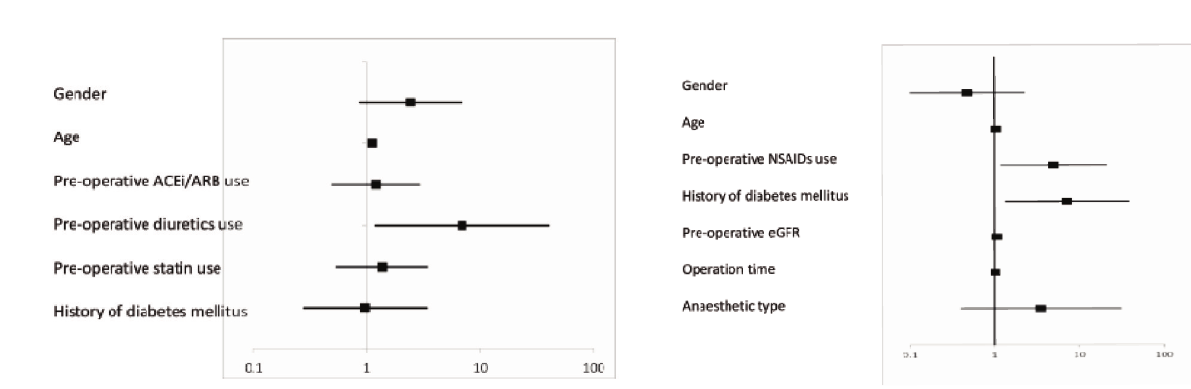
*CKD, chronic kidney disease; ACEi, angiotensin-converting enzyme inhibitor; ARB, angiotensin-II receptor blocker 95% Confidence Interval of factors associated with pre- Fig. 3: operative CKD.